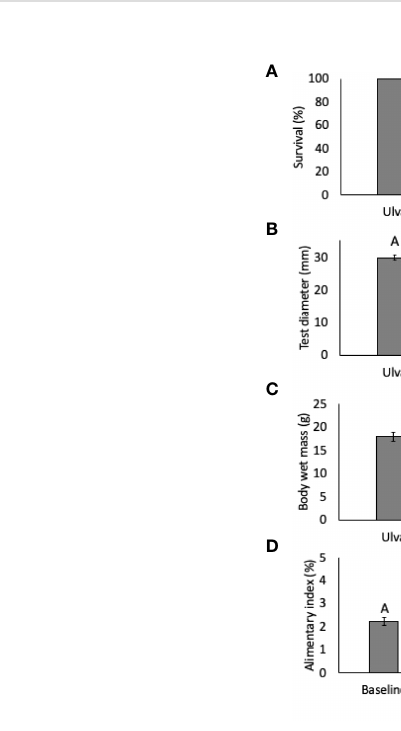
FIGURE 2 Mean (± SE) survival (%; A ), test diameter (mm; B ), whole animal wet mass (g; C ), and alimentary index (%; D ) of Arbacia punctulata fed different diet treatments. Letters above bars represent groups that are signi fi cantly different from each other, and where there are no letters indicate no signi fi cant treatment